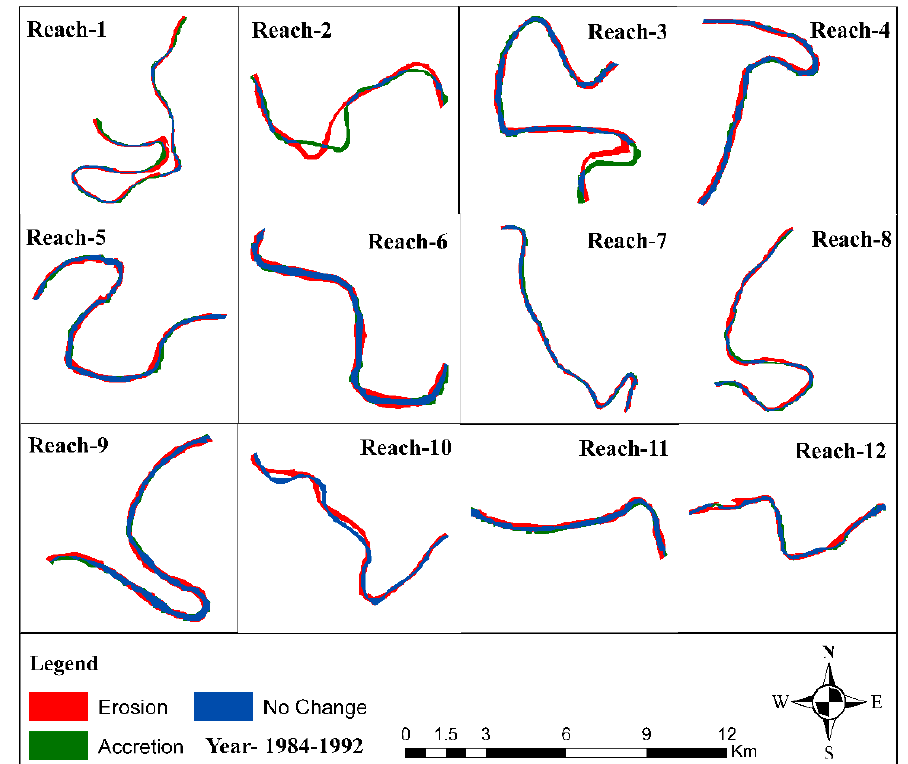
Figure 5. Map of erosion, accretion, and unchanged area between 1984 and 1992.